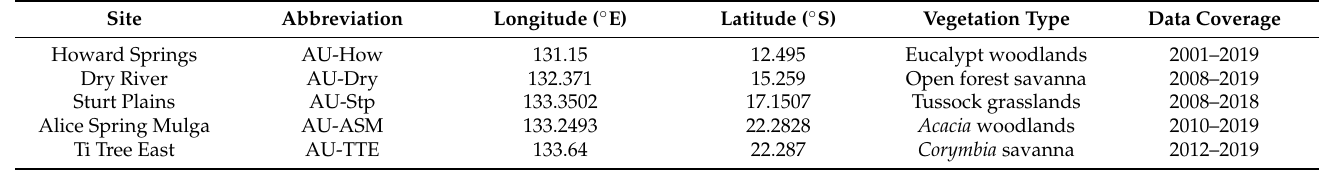
Table 1. Summary of five eddy covariance flux tower